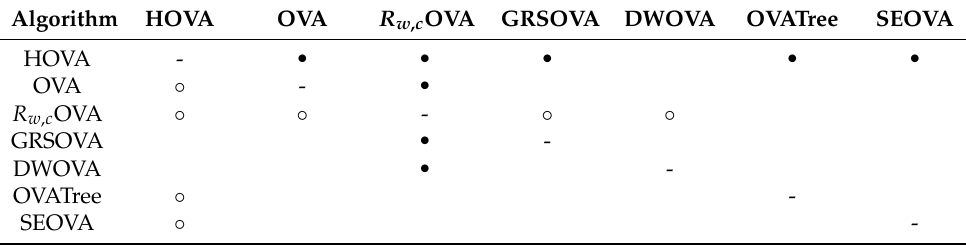
Table 7. Results of the Wilcoxon test with regard to HOVA.